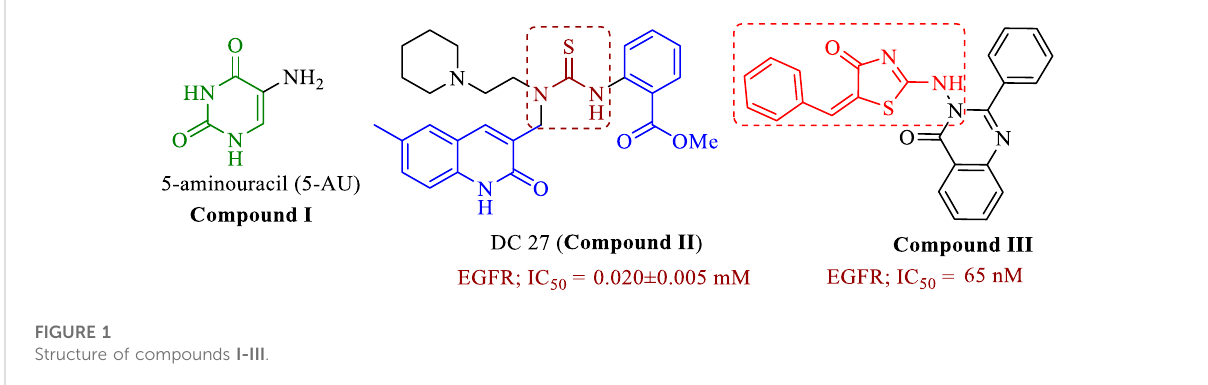
FIGURE 1 Structure of compounds I-III .